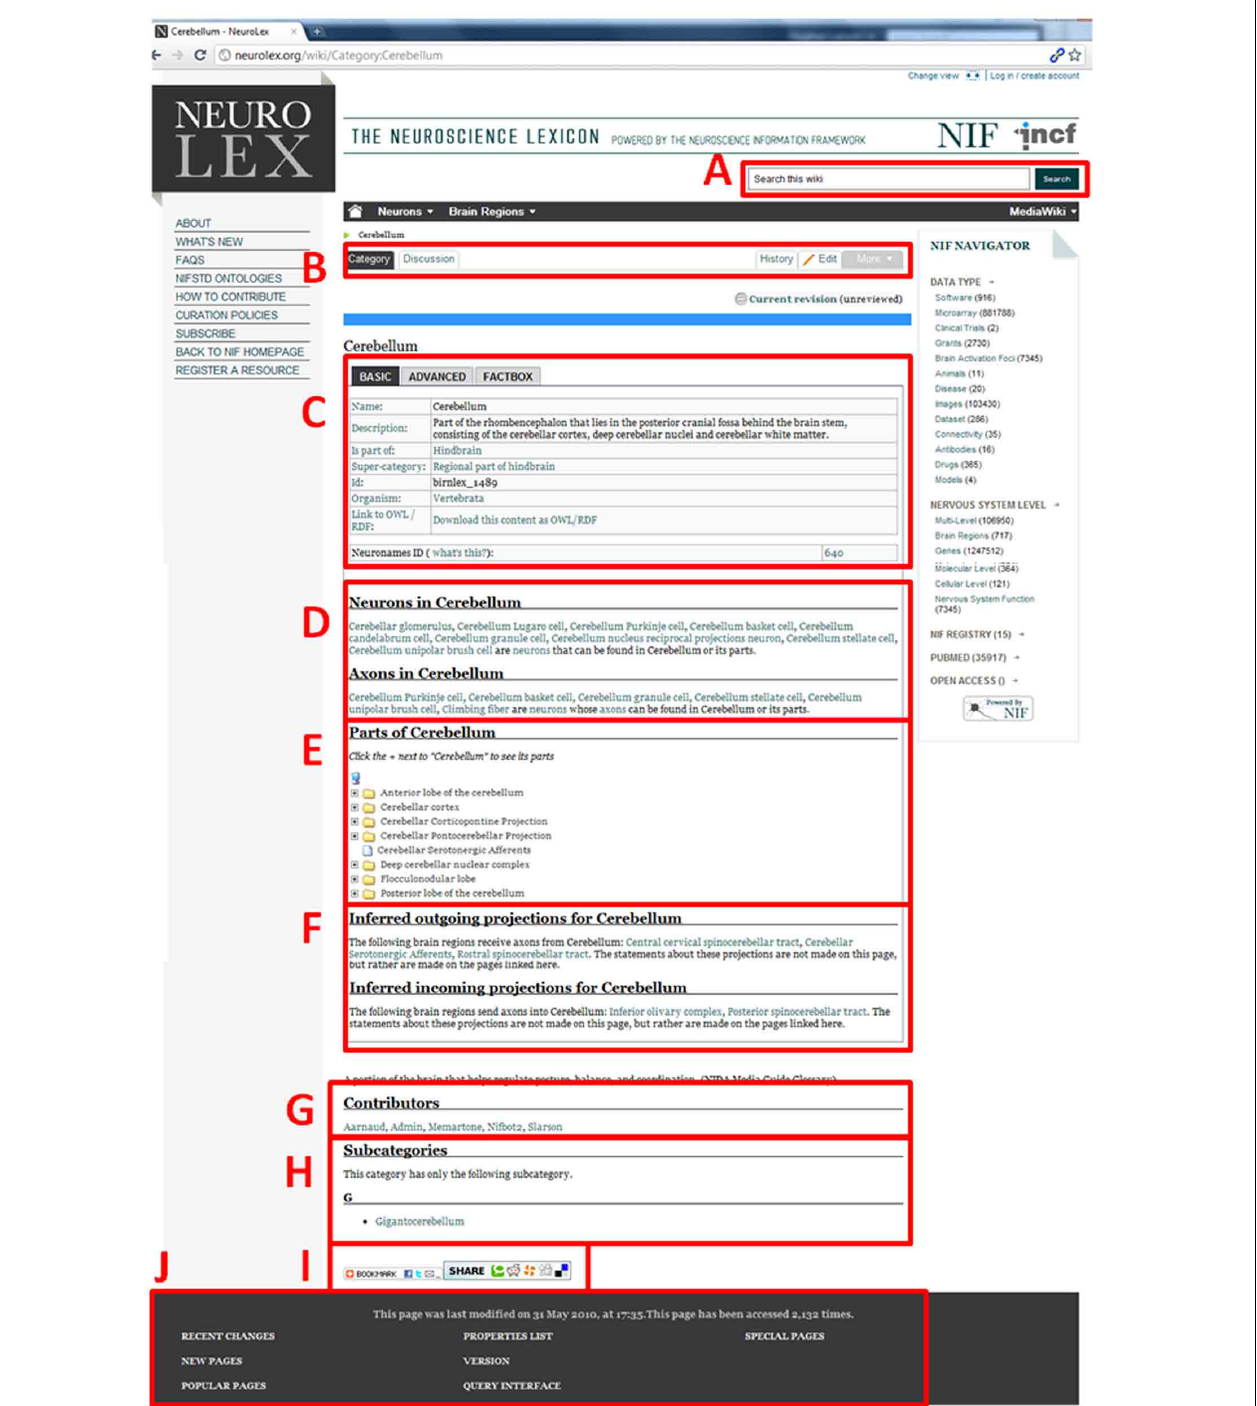
FIGURE 2 | Example category page for the concept entry ”Cerebellum” (A) Global site search bar. (B) Wiki controls for this page, including link to a discussion page, page edit history, and edit controls for this page. (C) Basic facts for this entry, including text description, super category and more. Tabbed interface also contains additional advanced facts. (D) Advanced auto-generated report for neurons whose somas or axons are located in the Cerebellum. (E) Advancedauto-generatedreportofotherbrain regionsthatare